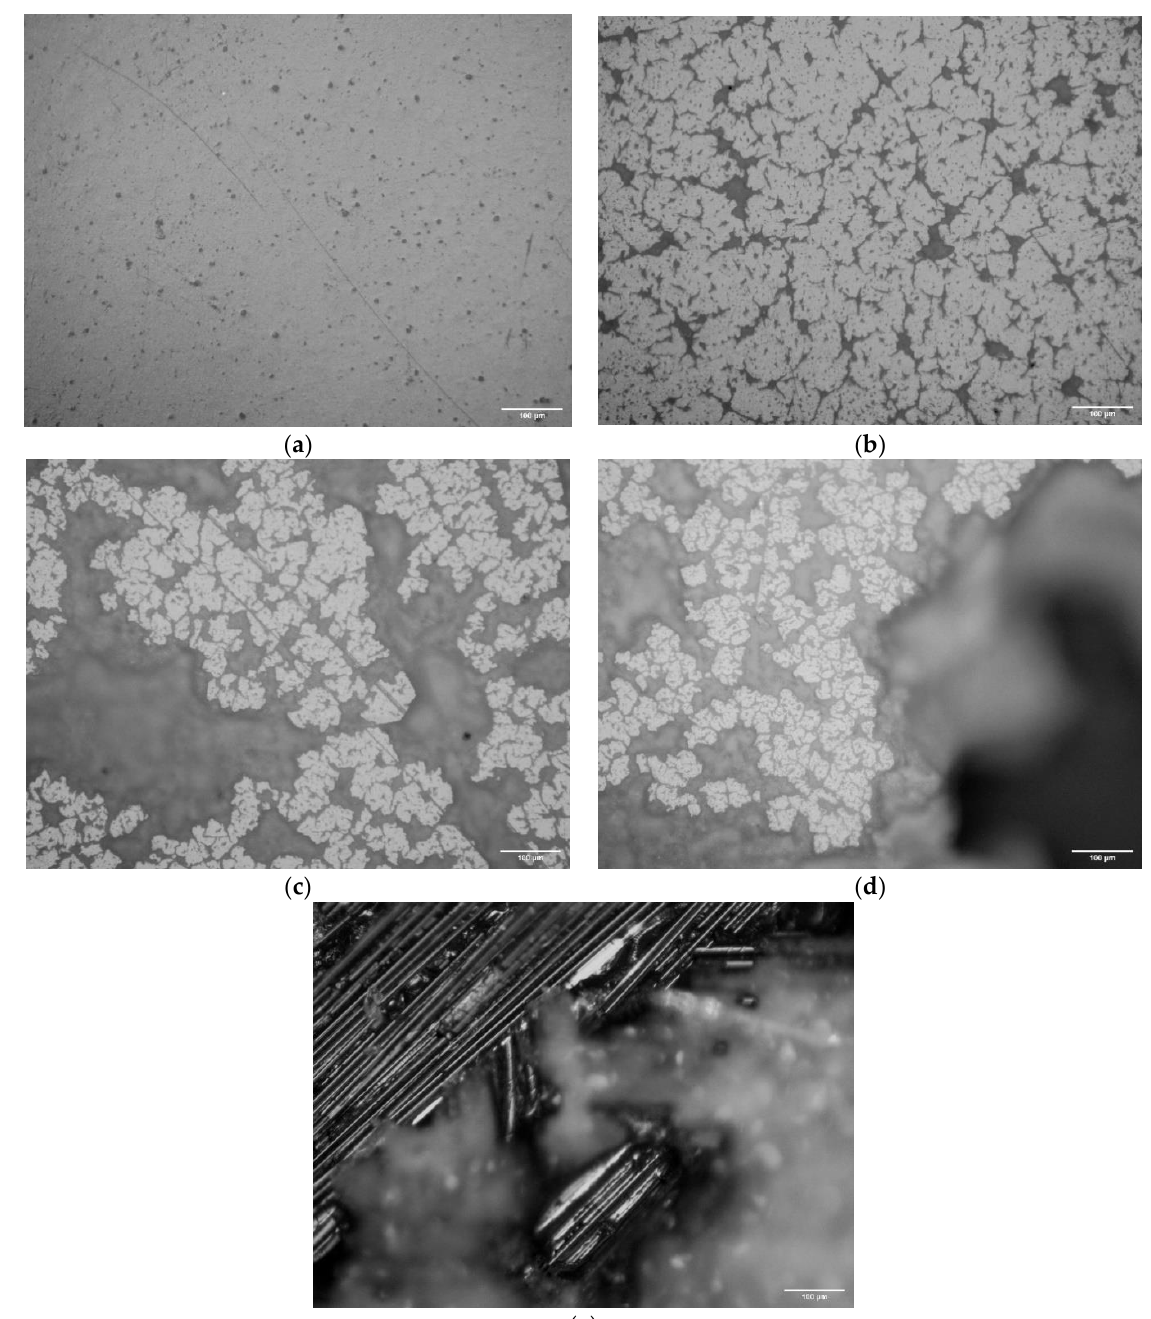
Figure 4. Microscopy images of samples from each erosion stage: ( a ) Stage 1; ( b ) Stage 2; ( c ) Stage 3; ( d ) Stage 4; ( e ) Stage 5.